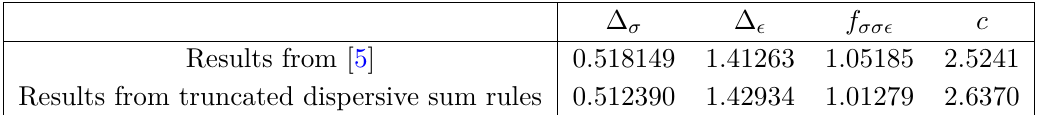
Table 12 . 3D Ising model data derived from 7 truncated dispersive sum rules that combine to provide 5 inequalities. These results were obtained by sampling N distributed quadratically around their expected